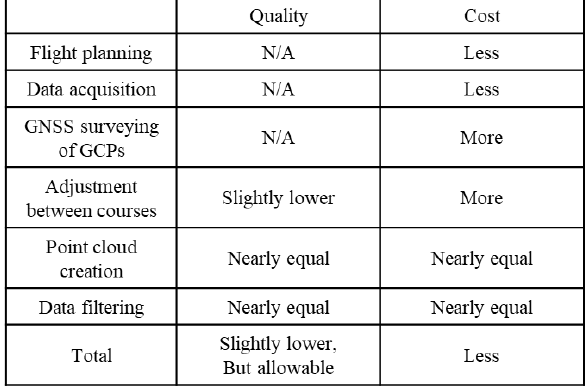
Table 8. Characteristics of ALS by a meandering flight in comparison with ALS by a straight-line